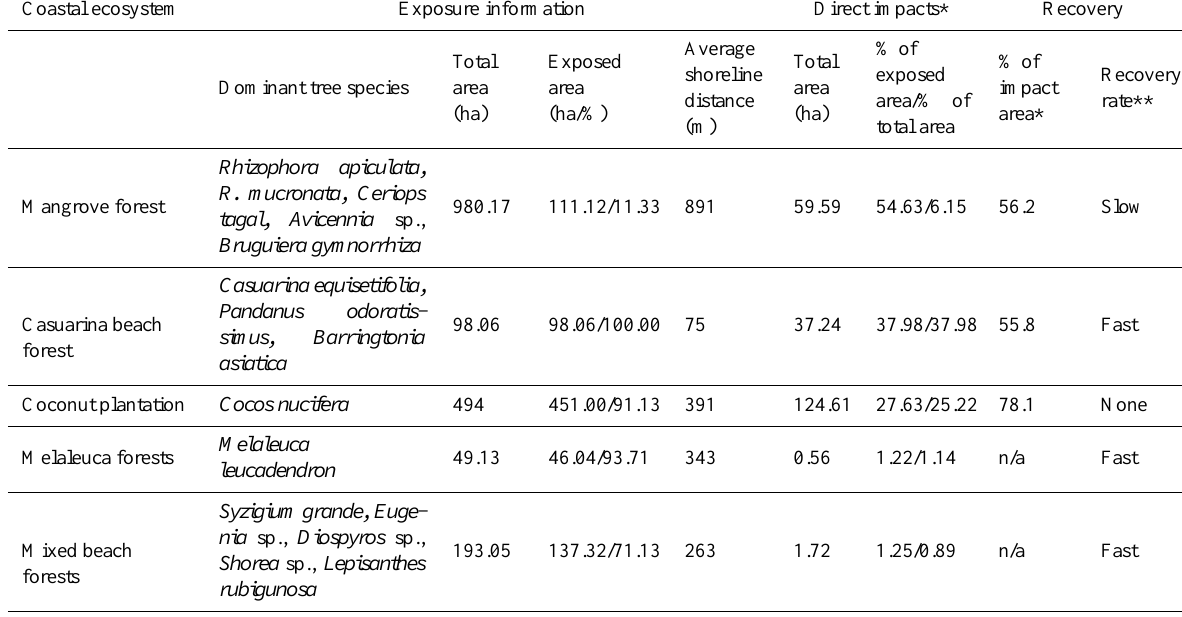
Table 7. Results of the analysis of ecological exposure, tsunami induced imapcts and recovery. Coastal ecosystem